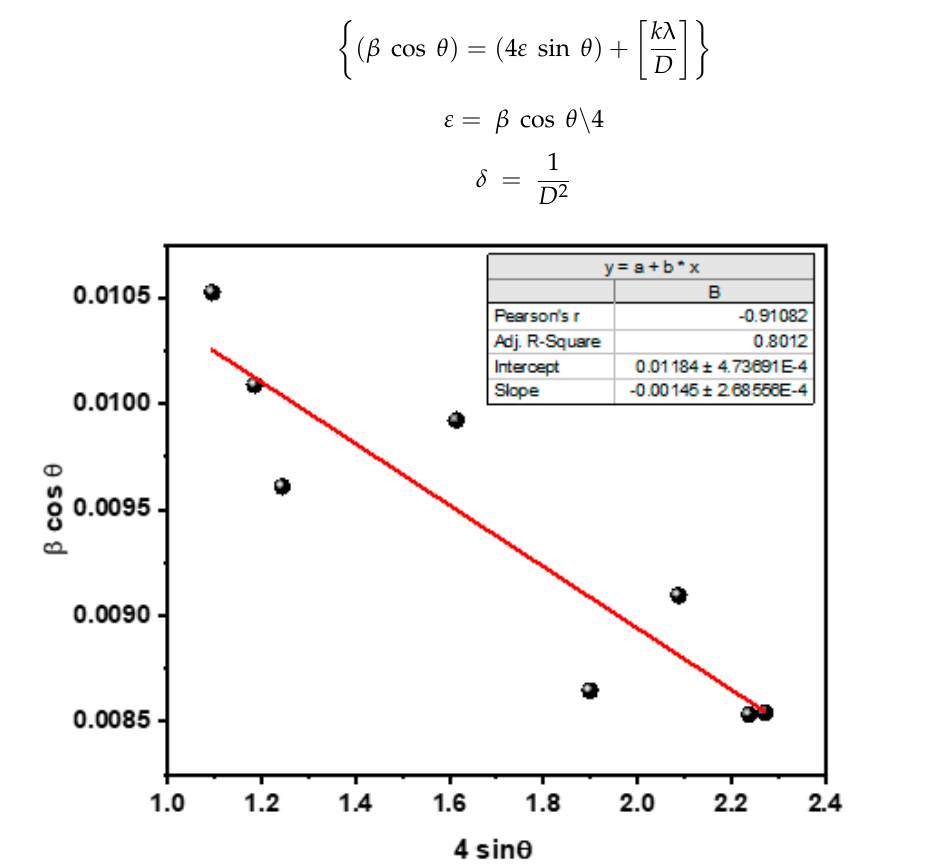
Figure 2. The W-H plot of the PUF/rGO/ZnO nanocomposite. The dislocation density was estimated to be 0.004598, while the micro strain was